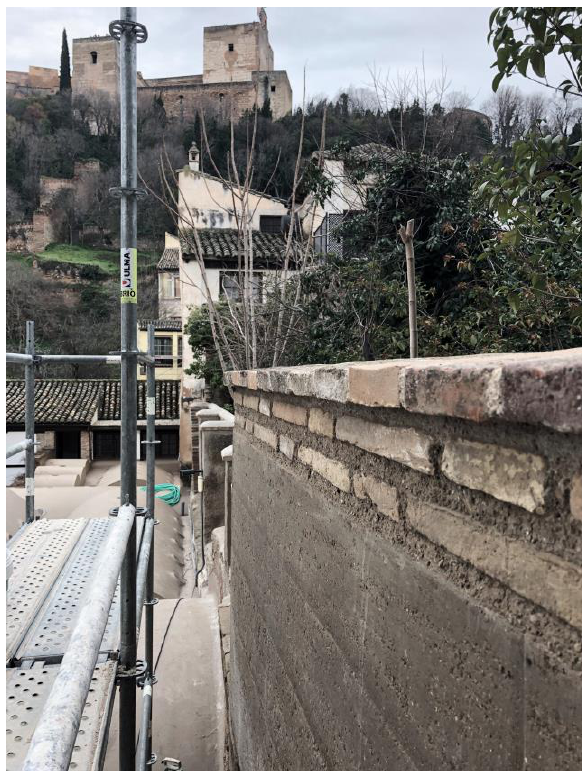
Figure 13. Courses and brick coping as upper auction of the rammed earth wall. At the bottom: the Alhambra of